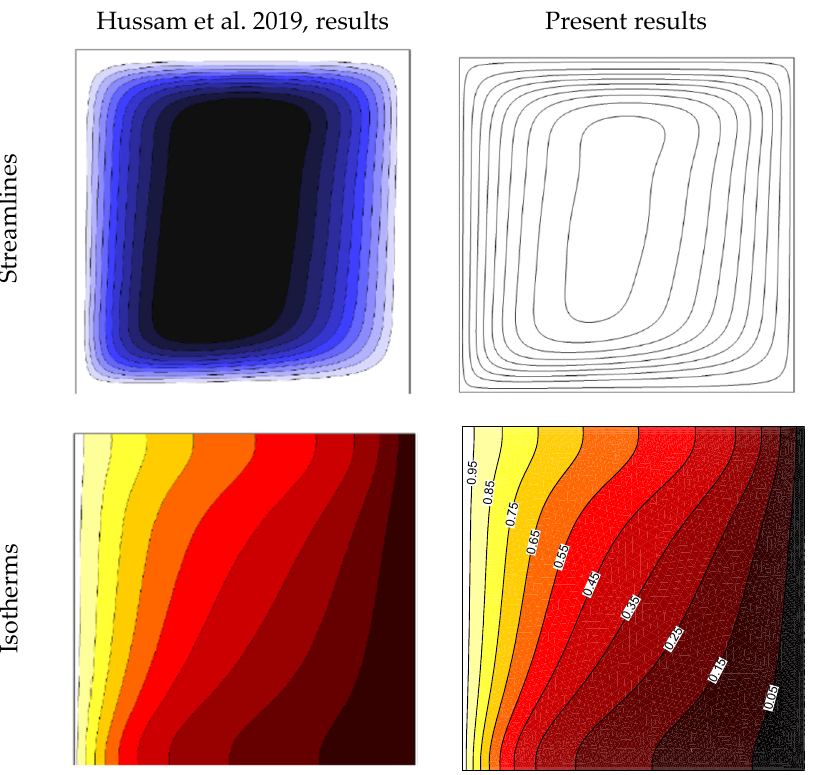
Figure 3. Comparison of present results with Hussam et al. [32] results at A = 0.5, f = 5, φ = 0.2, Ra = 10 6 , Ha = 100. Reprinted with permission from ref. [32]. Copyright 2019 Elsevier .